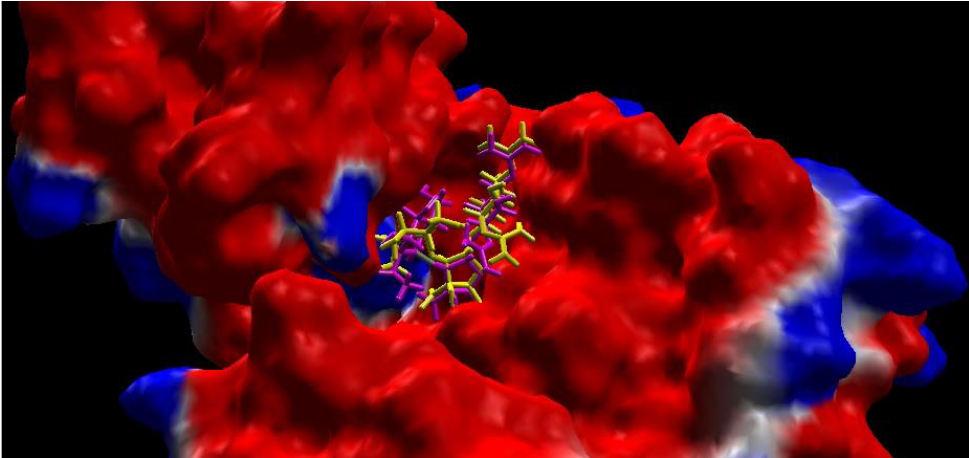
Figure 2. Comparison of the native ligand (streptomycin) (yellow) with the docking result simulation (purple) by Molegro Virtual Docker (MVD) Ver.5.5 with RMSD is 1.52 Å .